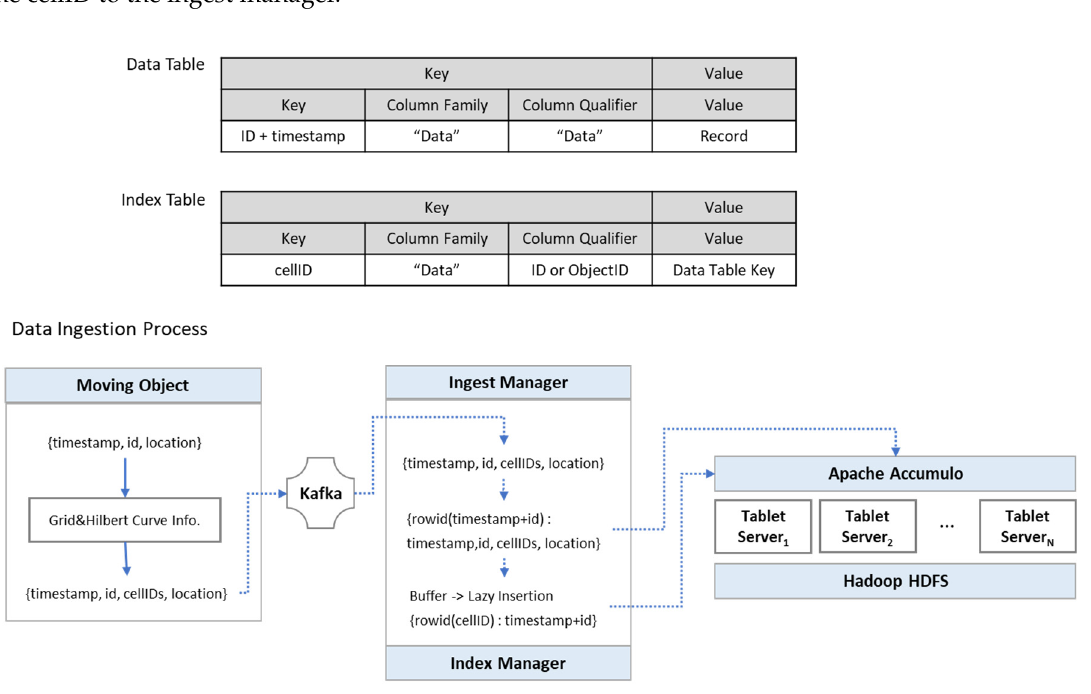
Figure 5. Proposed indexing method based on Hilbert Curve technique. Generally, locations of moving objects can be skewed to a specific area and the area may be changed with time. The indexing method described above cannot process efficiently the skewed